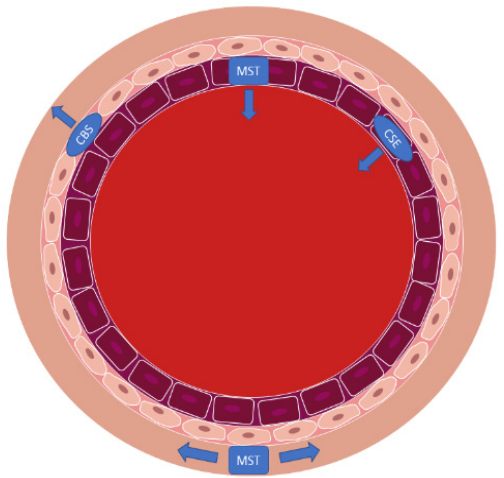
Figure 6. Diagram of blood vessel schematic of CSE, CBS, and MST within endothelial cells and smooth muscle. CSE is localized to the endothelial cells, CBS is primarily found in the smooth vascular muscle, and MST is seen in the surrounding vascular space and within the endothelial cells.